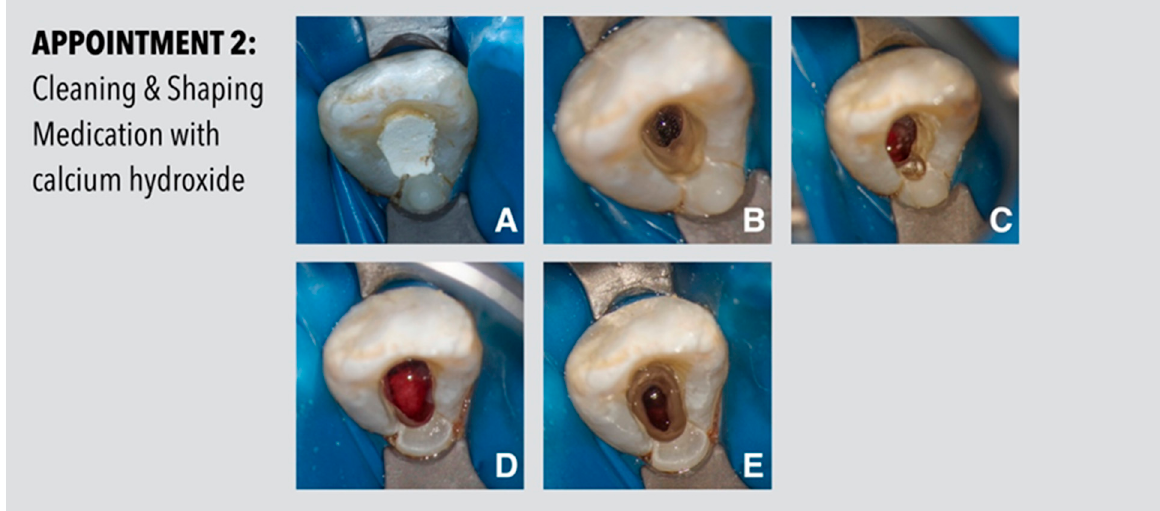
Figure 2. Procedures performed at the second appointment. ( A ) Temporized cavity suggesting a sufficiently extended access cavity. ( B ) After removal of the temporary material and inspection under the operating microscope a palatal overhang is visible: the invaginated tooth structure has not yet been incorporated into the access cavity. ( C ) Extension of the access cavity and removal of the invaginated tooth structures. ( D ) View of the fully extended access cavity with optimal access to the endodontic system. ( E ) Situation after disinfection and before placement of calcium hydroxide.